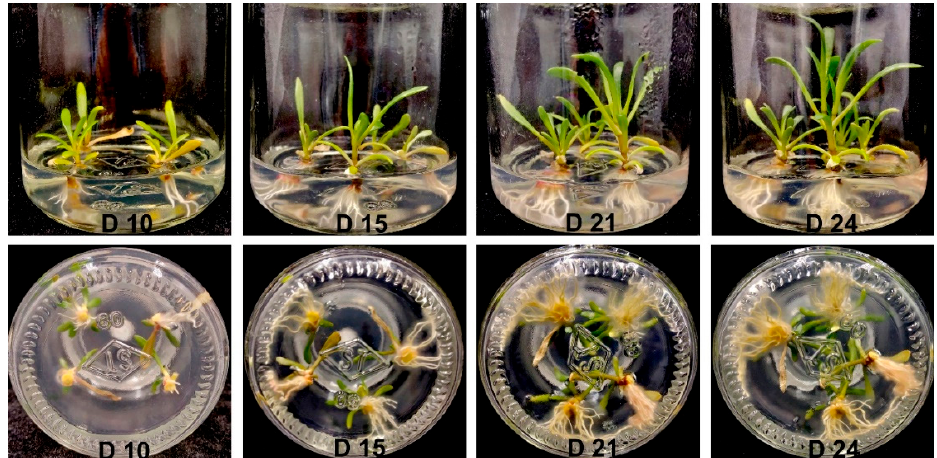
Figure 4. Microcuttings of S. portulacastrum rooted on half-strength MS medium supplemented with 0.6 mg L − 1 IBA from day 10 (D 10) to day 24 (D 24) (upper panel). The lower panel shows the increase in root numbers viewed from the bottom of culture vessels. Table 3. Effect of half-strength MS supplemented with different concentrations of IBA or IAA on in vitro rooting of S. portulacastrum over 24 days.